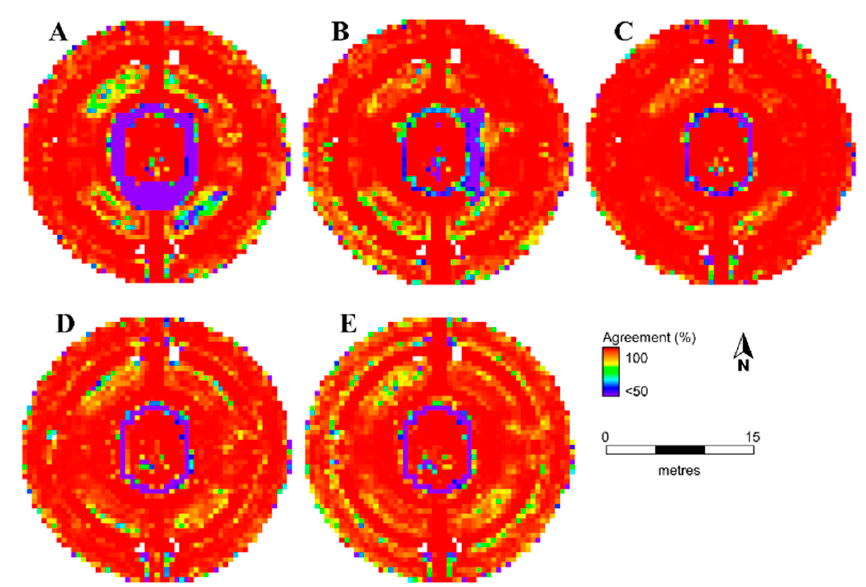
Figure 4. Rasterized classification agreement for the inverted cloth simulation ( A ), hierarchical weighted robust interpolation ( B ), progressive TIN densification ( C ), multi curvature classification ( D ), and modified slope-based filter ( E ) for the garden site.